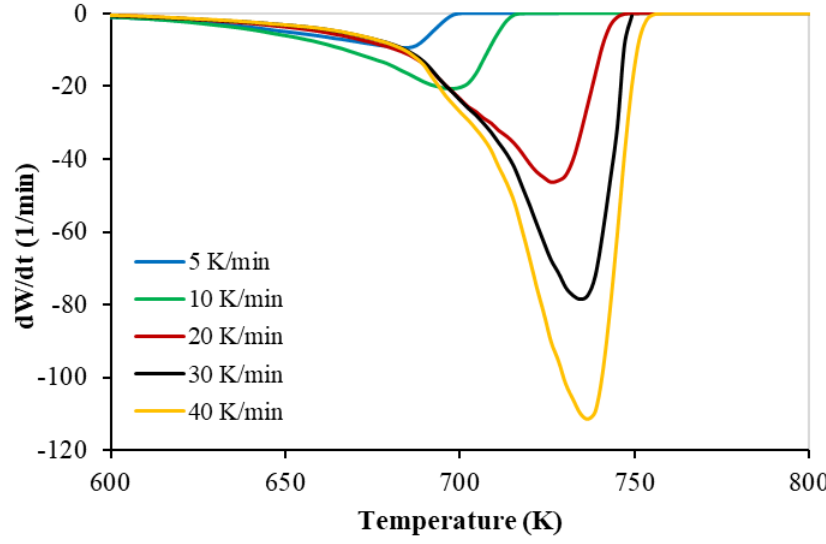
Figure 2. Derivative thermogravimetric (DTG) curves of the PP pyrolysis with different heating rates. Table 5. Onset, peak, and final temperatures for five tests. Test